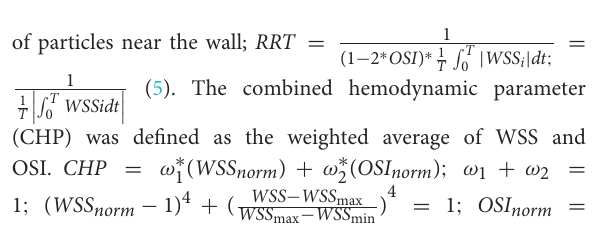
of particles near the wall; RRT